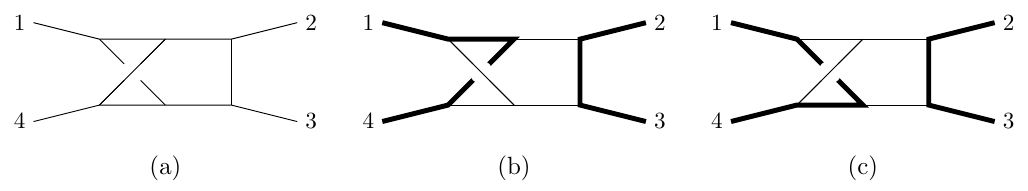
Figure 1. Example of KK reduction with massless exchange. The diagram in (a) reduces to the pair of diagrams in (b) and (c). The thin and thick lines denote massless and massive momenta